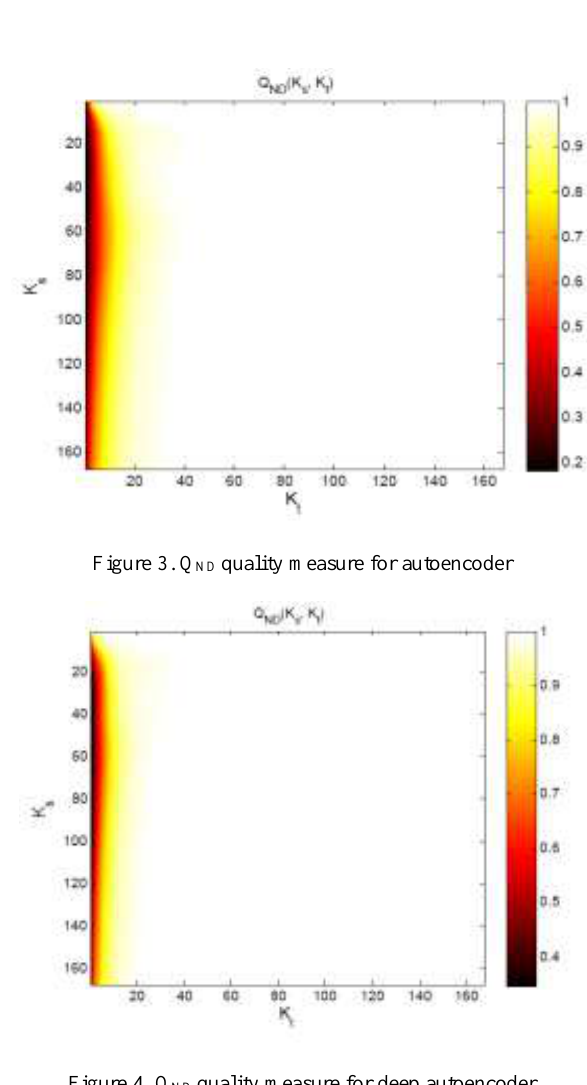
Figure 4. Q ND quality measure for deep